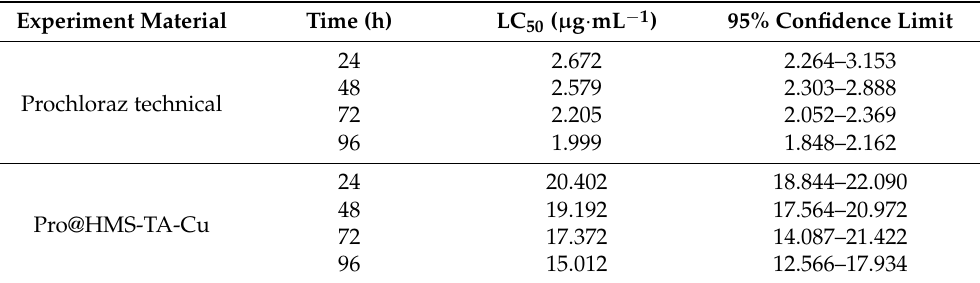
Figure 9. The survival of zebrafish treated with prochloraz technical ( A ) and Pro@HMS-TA-Cu nanoparticles ( B ) at 24, 48, 72, and 96 h. Table 3. The LC 50 values of prochloraz technical and Pro@HMS-TA-Cu to zebrafish at 24, 48, 72, and 96 h.